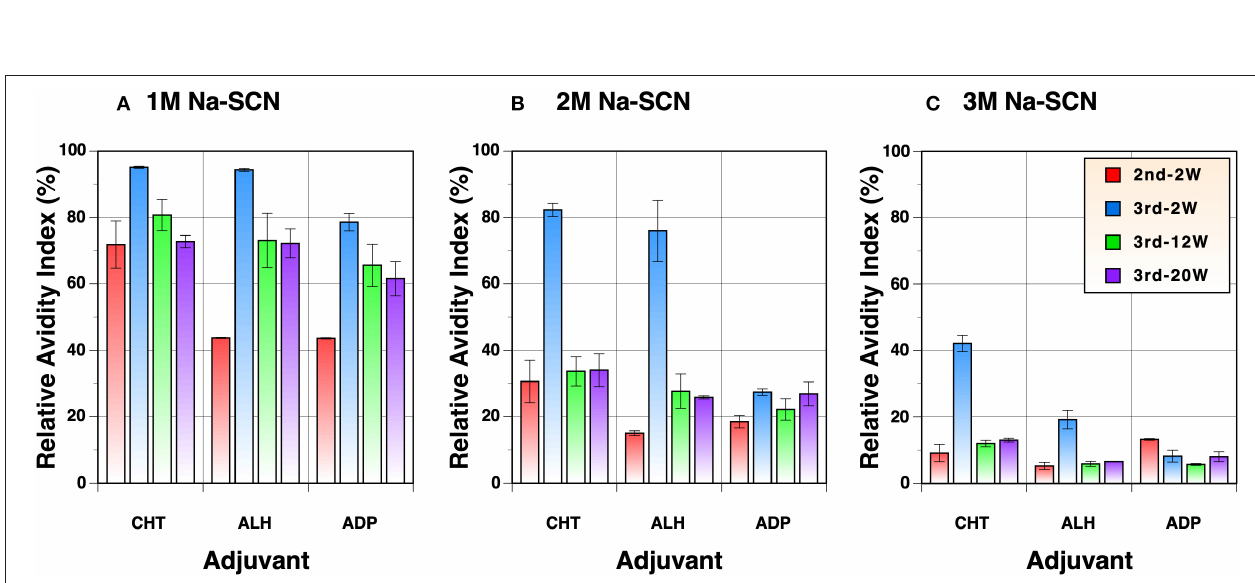
FIGURE 6 | Avidity of antibodies against the RBD. ELISA was done in the presence of (A) 1M, (B) 2M or (C) 3M NaSCN and compared to without to determine relative avidity index. Serum samples collected 2 weeks after the second and 2, 12, or 20 weeks after the third immunizations were evaluated at 1:1,800 dilution.